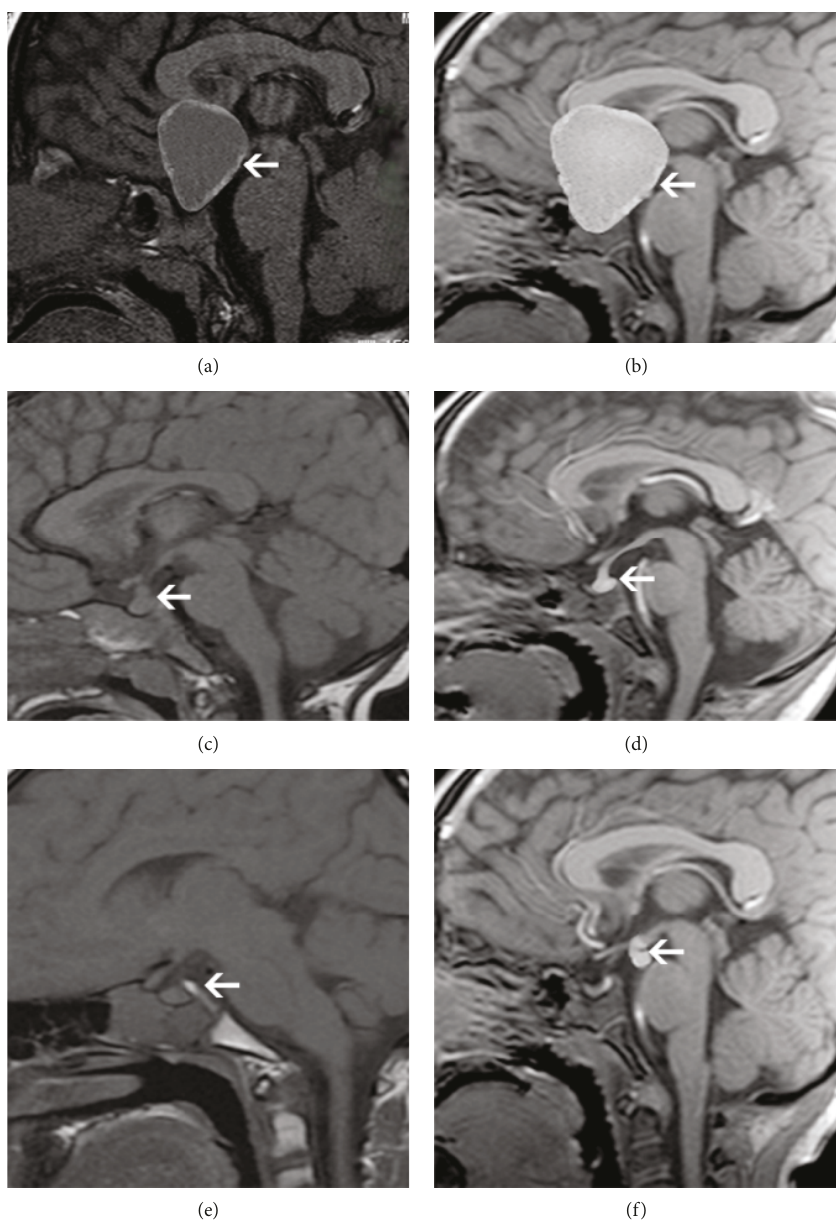
Figure 1: Etiological classi fi cation of CDI. Craniopharyngioma: (a) T1WI image showed tumor (white arrowhead); (b) 3D examination showed clearer uniform tumor (white arrow). Intracranial germinoma: (c) T1WI image showed that the upper edge of the pituitary was uplifted, and the posterior high signal was not shown, and the pituitary stalk was thickened (white arrow); (d) the enhanced examination showed that the pituitary stalk and pineal gland were uniformly nodular (white arrows). Langerhans cell histiocytosis: (e) T1WI showed a thickening of the pituitary stalk, showing T1 and other T2 signals, clear edges, pressure in the third ventricle, disappearance of the funnel crypt, slightly increased pressure in the optic chiasm, and no signal in the posterior pituitary; (f) the enhanced scan showed mild even enhancement of the mass, and the anterior pituitary was less